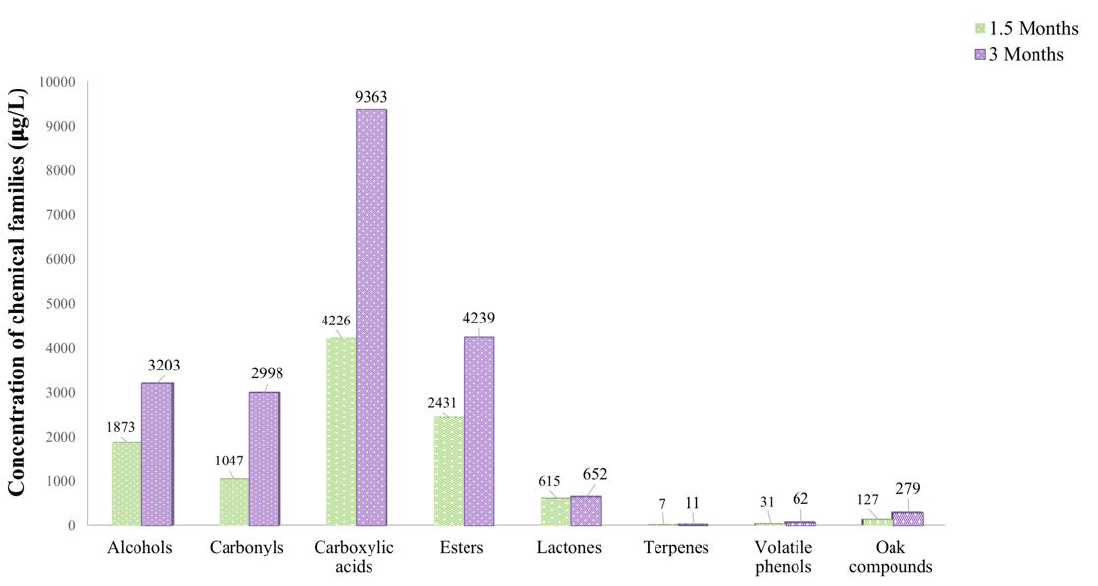
Figure 2. Concentration of chemical families ( µ g/L) in wines aged with oak staves at 1.5 and 3 months.